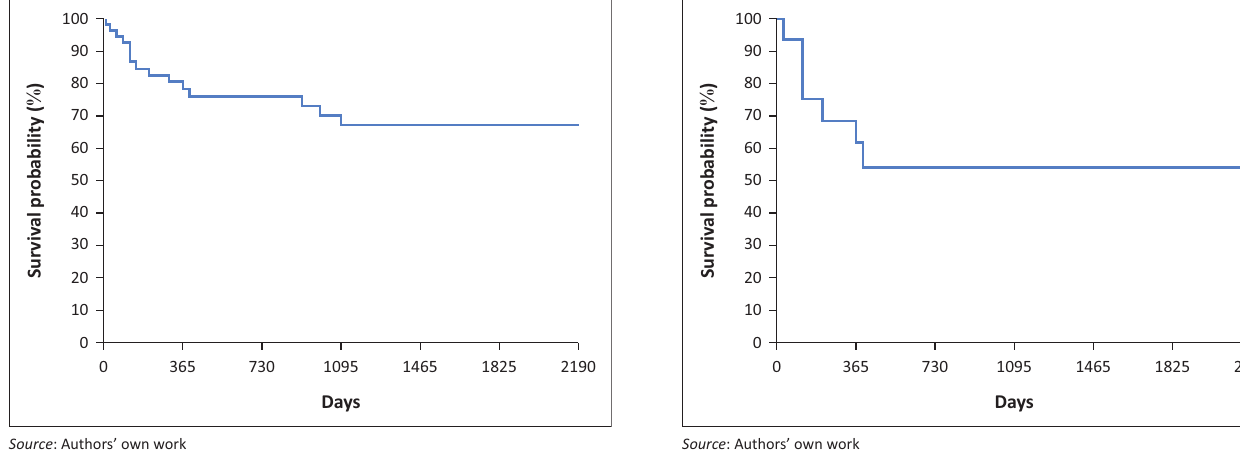
FIGURE 3: Kaplan Meier graph. Overall survival of the studied patients diagnosed with benign and malignant neonatal tumours.